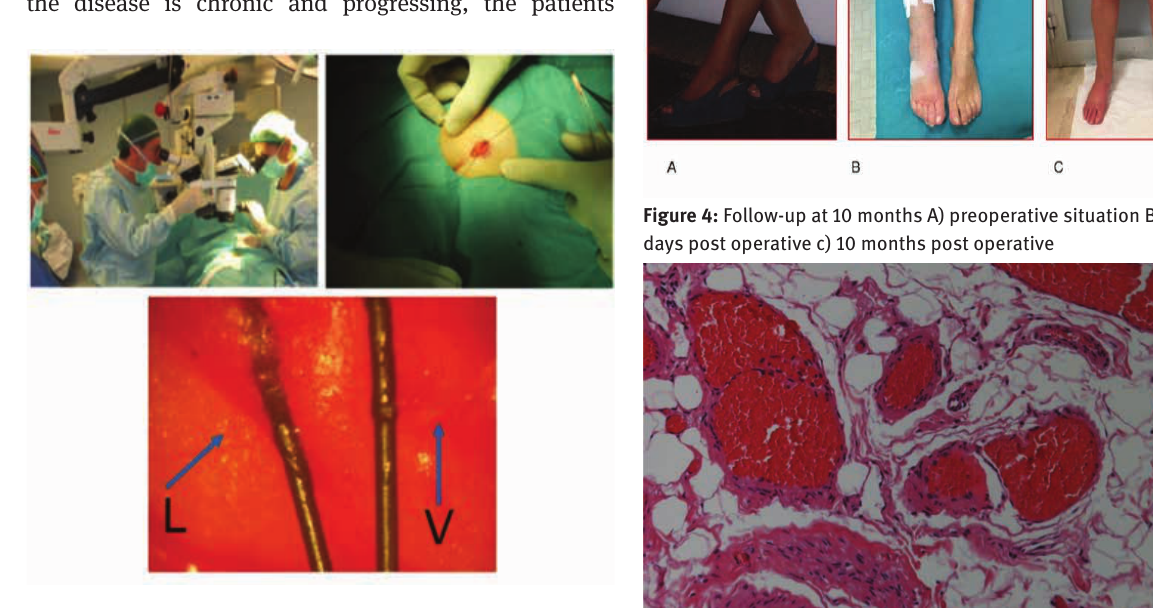
Figure 3: sequence for execution of lymphatic venous anastomosis by technique supermicrosurgery performed by mini incision of 1 cm and packed to the operating microscope 20 magnification, in detail L indicates the lymphatic and V the vein.